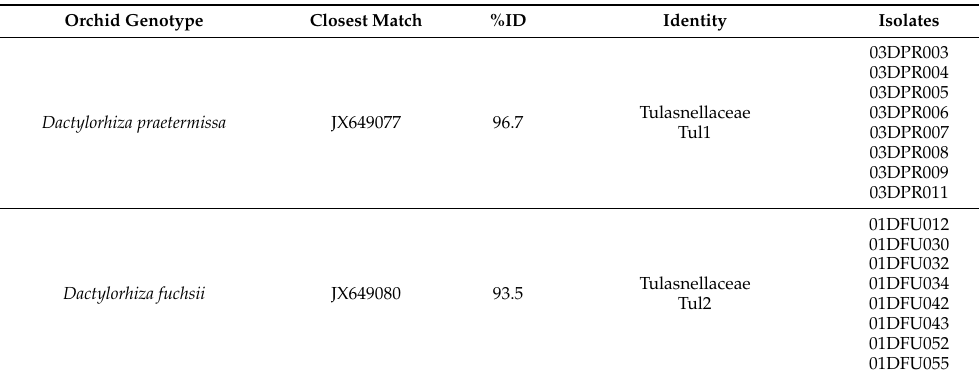
Table 1. Source of mycorrhizal fungi, closest match, and isolates used for preliminary seed germina- tion trials of Dactylorhiza incarnata subsp. ochroleuca .